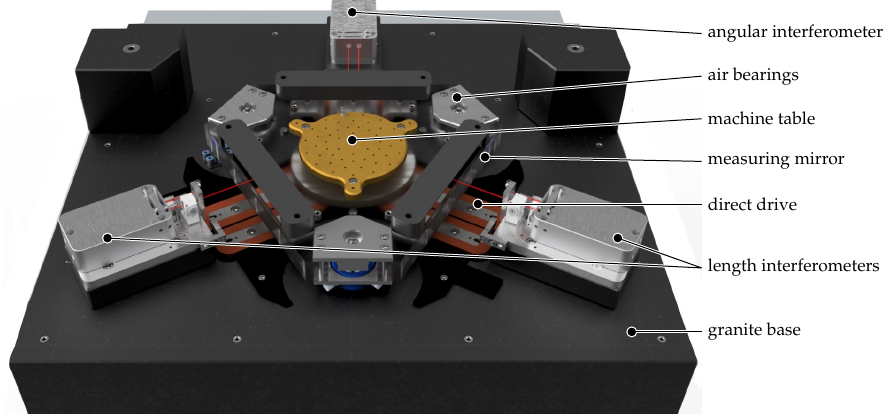
Figure 2. CADmodel of the Nanofabrication Machine (NFM-100). The AFM measuring system is mounted directly above the center of the machine table but is not depicted here for better visibility of the